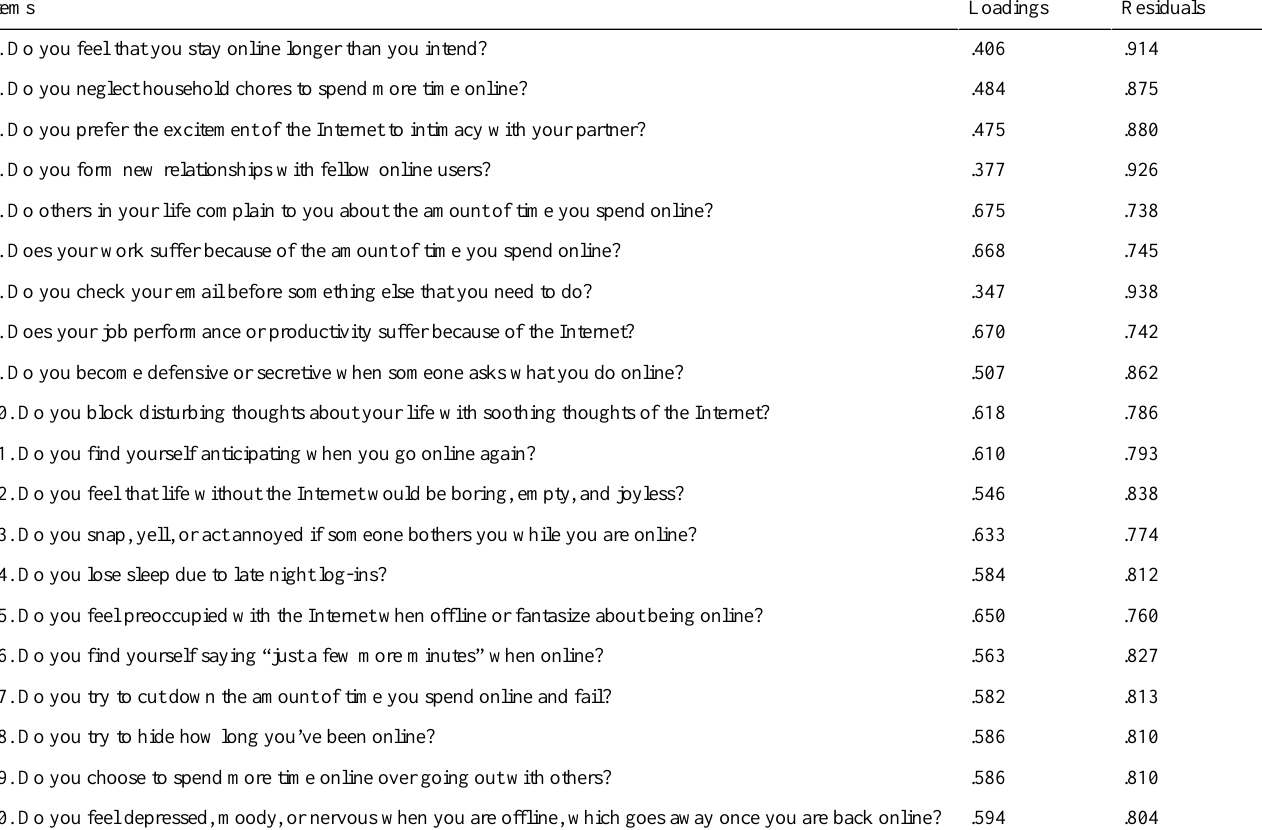
Table 4. Standardized factor loadings of the IAT items for the one-factor solution.